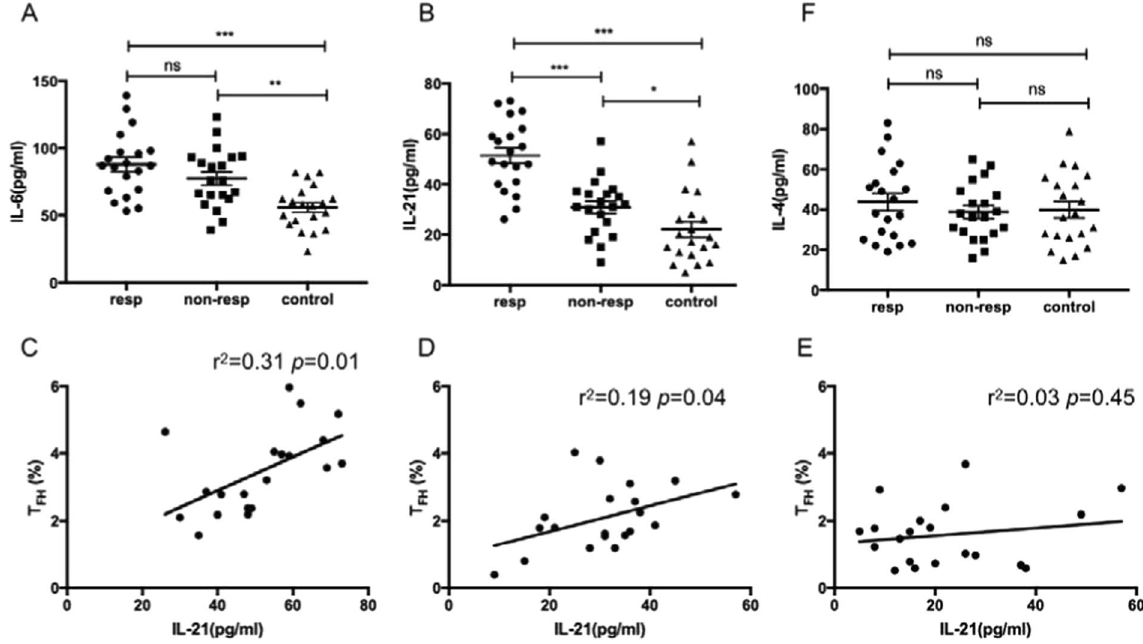
Figure 4. Relative cytokine levels in the AIHA mouse model. ( A ) Levels of serum IL-6 in the responder, non- responder, and control groups in the 12 weeks after the first immunization. ( B ) Levels of serum IL-21 in these three groups in the 12 weeks after the first immunization. ( C – E ) Relationship of serum IL-21 levels and the percentage of CXCR5 + CD4 + CD25 − T FH cells in these three groups, respectively. ( F ) Levels of serum IL-4 in these threegroups in the 12 weeks after the first immunization. Each plot represents one mouse in each group. This experiment was repeated three times with 6–7 mice in each group. Data shown were the mean ± SEM. * p < 0.05; ** p < 0.01; *** p < 0.001; ns, no significance.